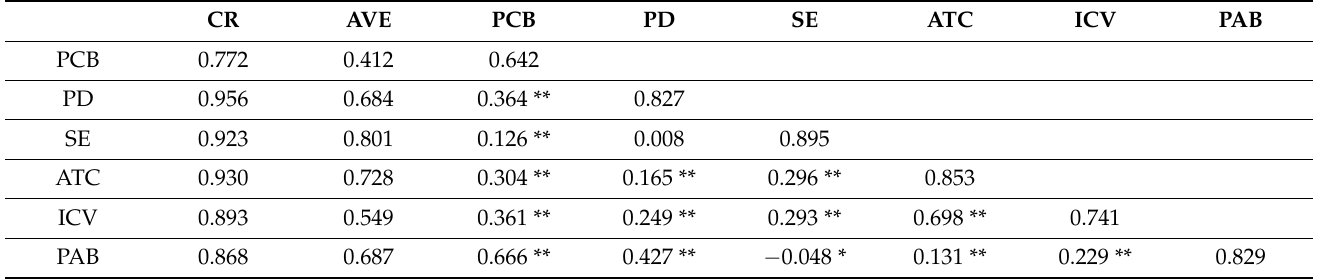
Table 3. Correlation matrix, the reliability and discriminant validity of